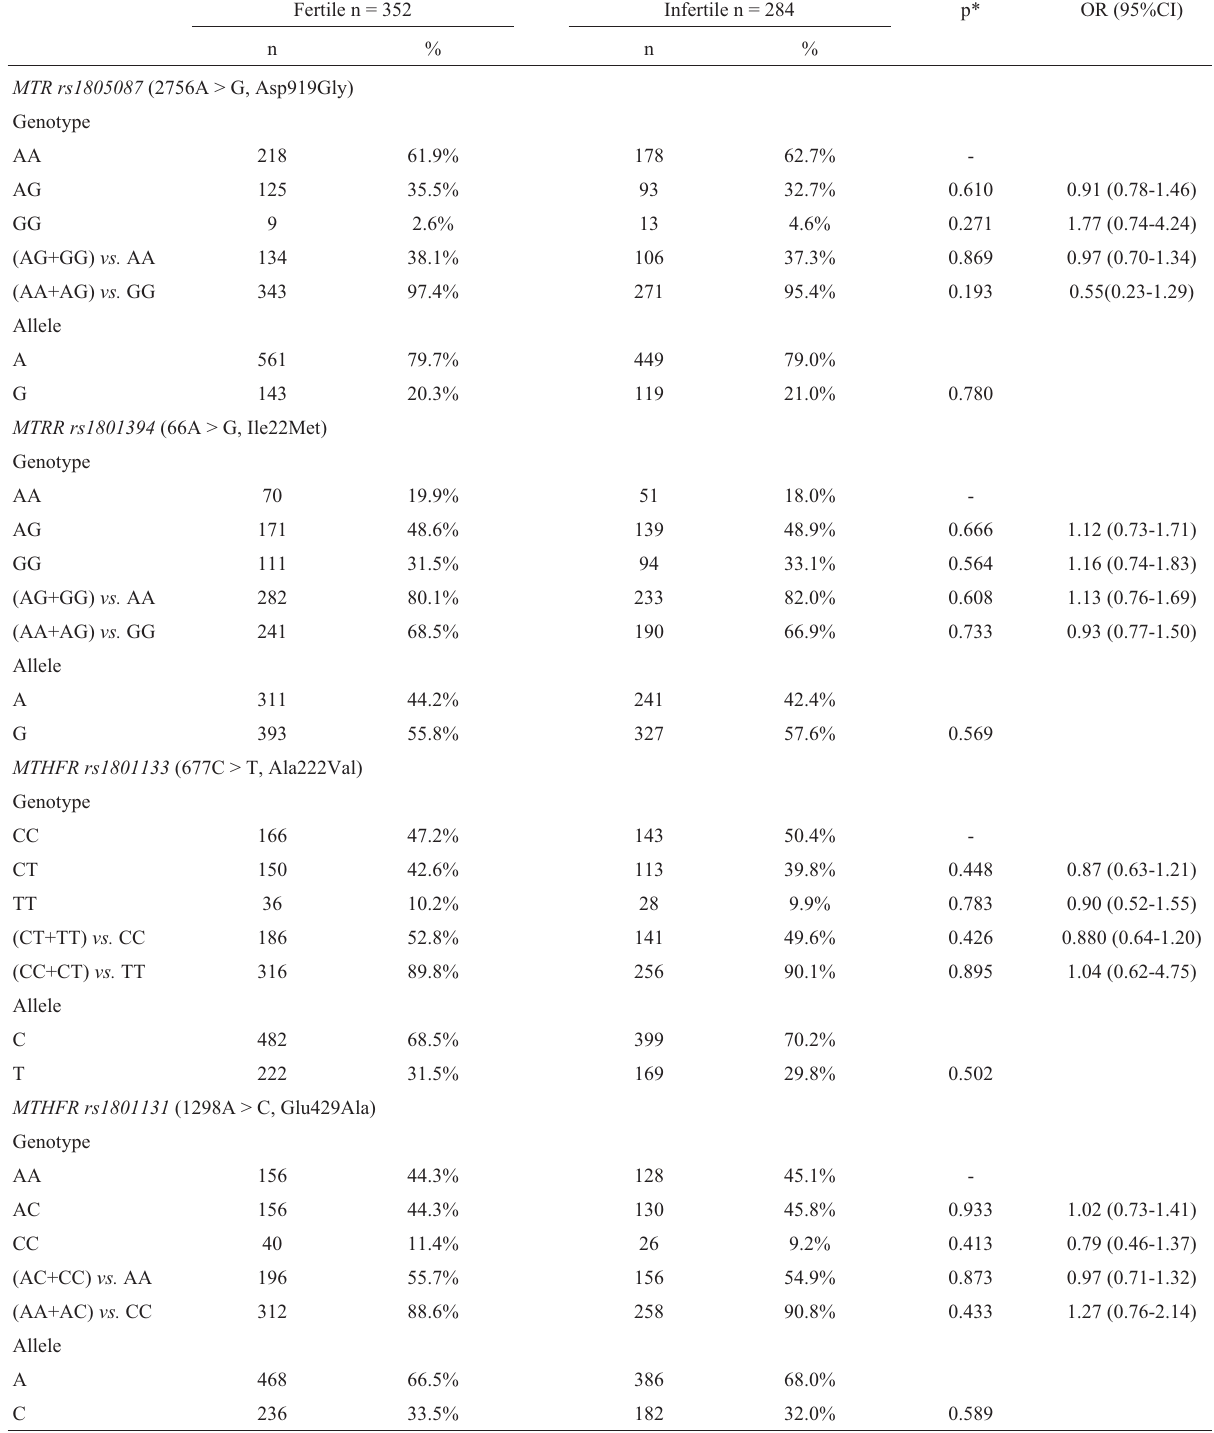
Table 1 - Distribution of MTR , MTRR and Fluorescence data after 40 PCR cyclesMTHFR gene variants in infertile patients and control group. Fertile n = 352 Infertile n =